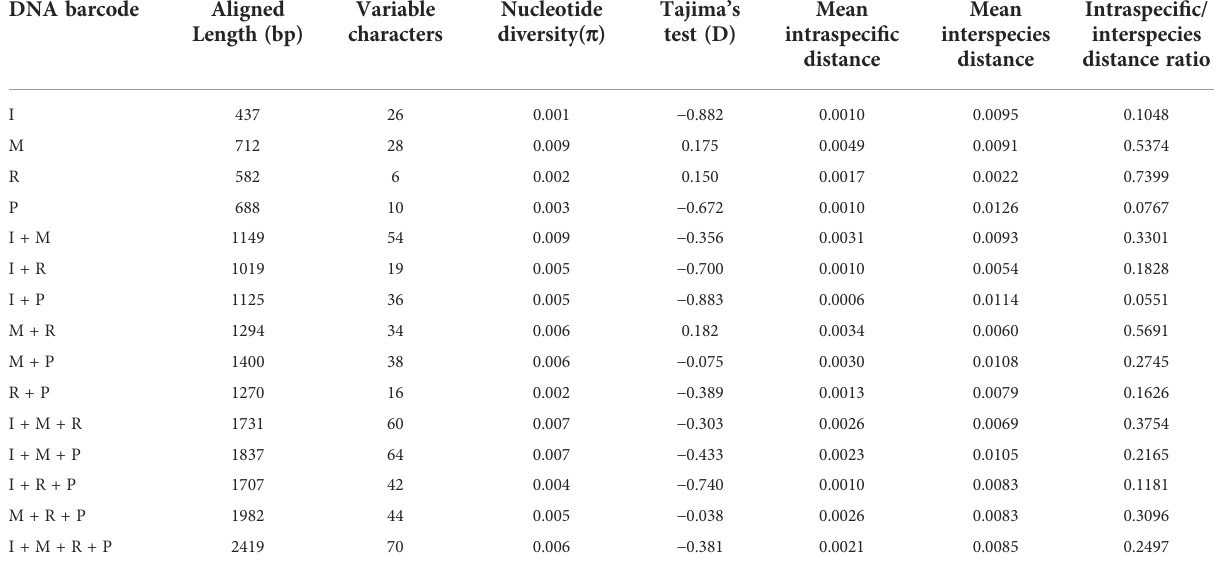
TABLE 4 Information and genetic diversity of candidate DNA barcode regions. DNA